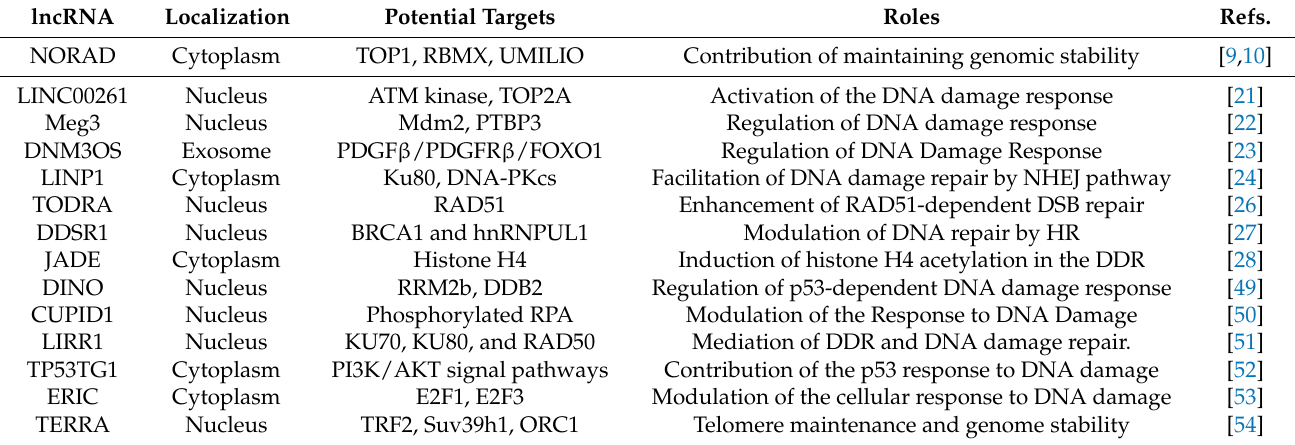
Table 3. LncRNAs involved in DNA damage/repair. NHEJ: nonhomologous end